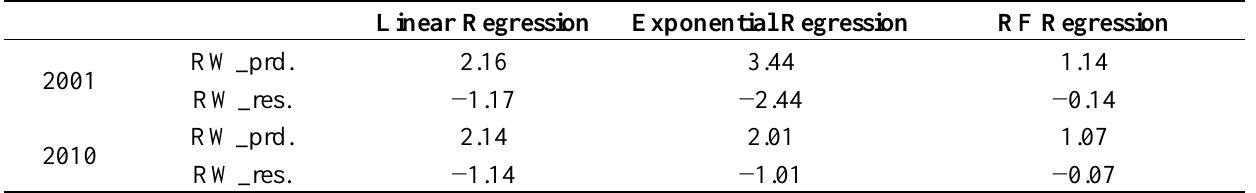
Table 2. The relative weight of the predicted and residual annual rainfall fields for the three techniques for the year of 2001 and 2010 over Mainland